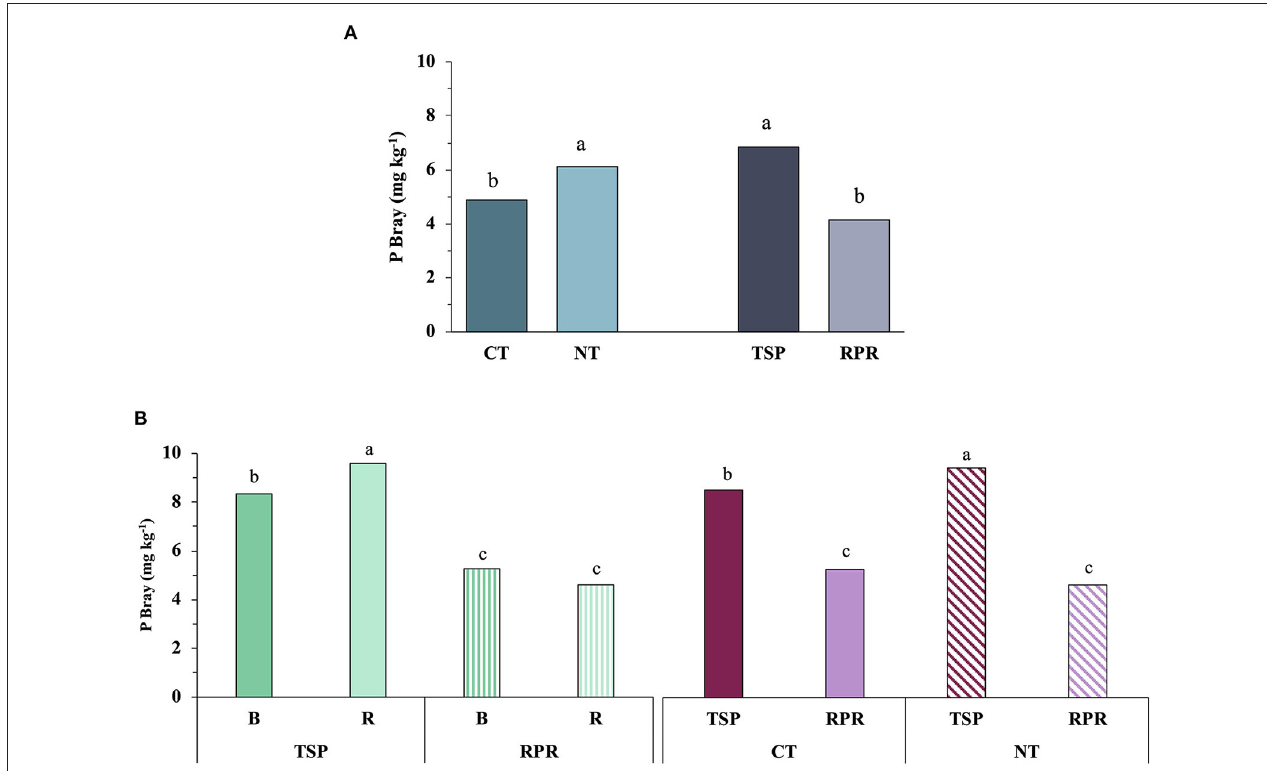
FIGURE 2 | Soil P availability (Bray-1) in the 0–20cm layer in a very clayey Oxisol under different soil tillage systems and phosphate fertilization managements after 14 years/crops (A) and 17 years/crops (B) of cultivation. Letters compare levels within a factor in (A) and within 2-factor interactions in (B) according to the LSD test (P < 0.05). NT, no tillage; CT, conventional tillage; TSP, triple superphosphate; RPR, reactive phosphate rock; B, broadcast; R, row.